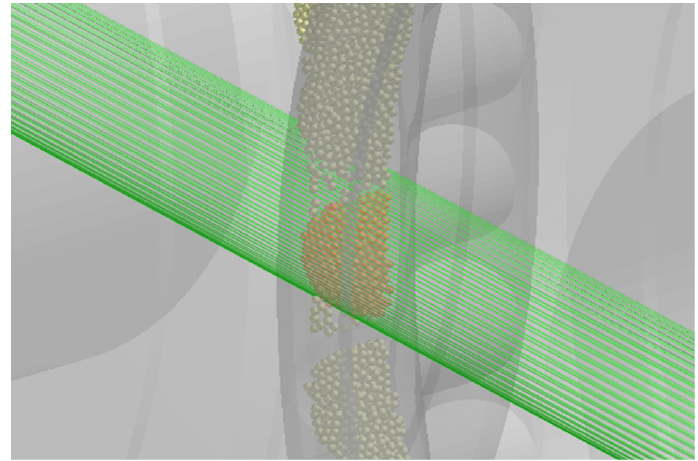
Figure 5. Location of the briquette weight measurement sensor in the model.